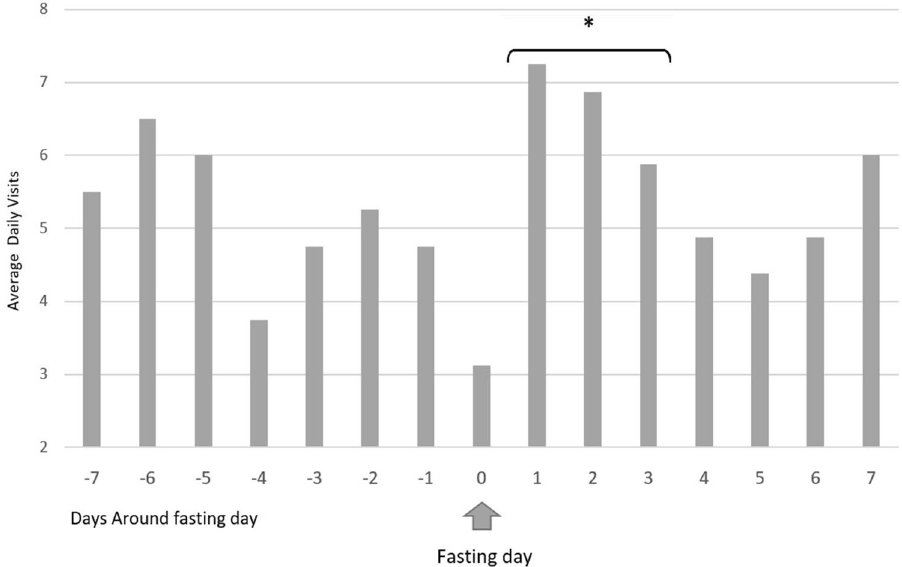
Figure 2. Average daily emergency room visit distribution around the day of Yom Kippur (single day fasting). *Average daily visits during the first 3 days following Yom Kippur.